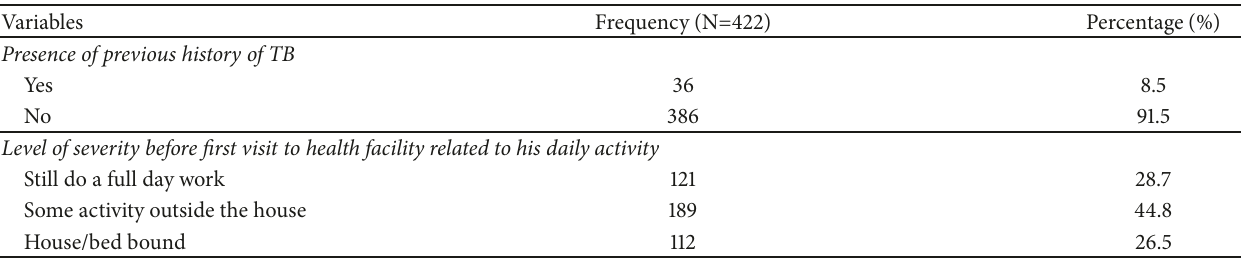
Table 2: Clinical profile of study participants among selected health facilities of Gedeo Zone, Southern Ethiopia, 2017/18.